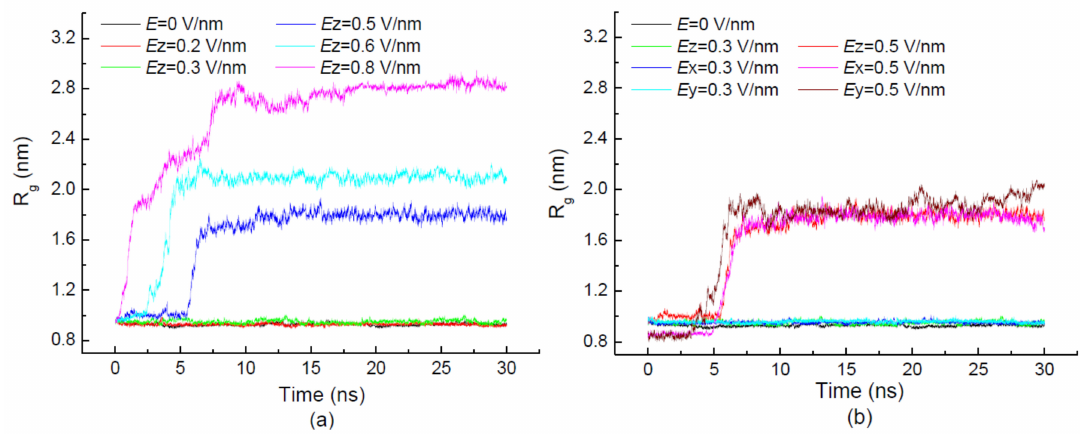
Figure 1. (Color online) Time evolution of root mean square deviation (RMSD) of the protein 1BBL exposed in the external electric fields with different strengths ( a ), along opposite z -directions ( b ), and along three different directions ( c ),